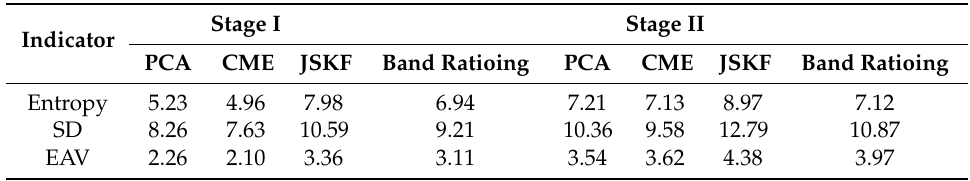
Figure 6. Visual comparison of band selection using the PCA, CME, JSKF and band ratioing. Table 4. Quantitative evaluation of band Table 4. Quantitative evaluation of band selection.